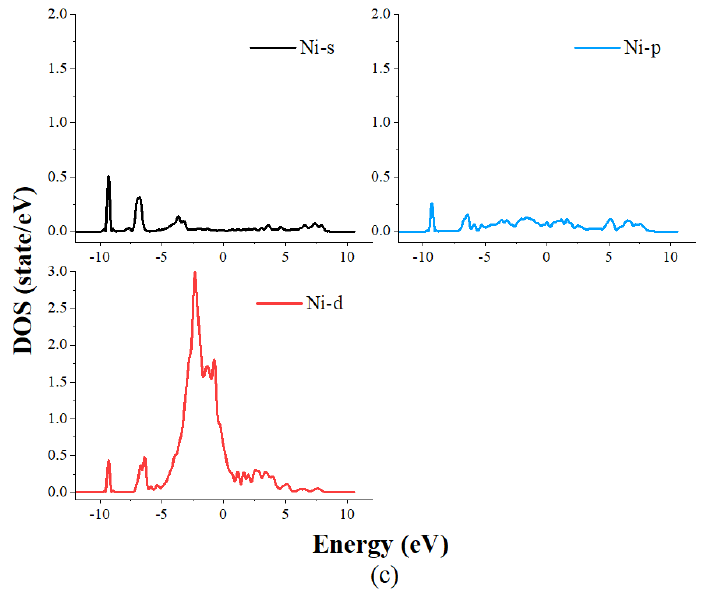
Figure 9. Density of the orbital states for each atom after adsorption: ( a ) carbon atom; ( b ) oxygen atom; ( c ) nickel atom.